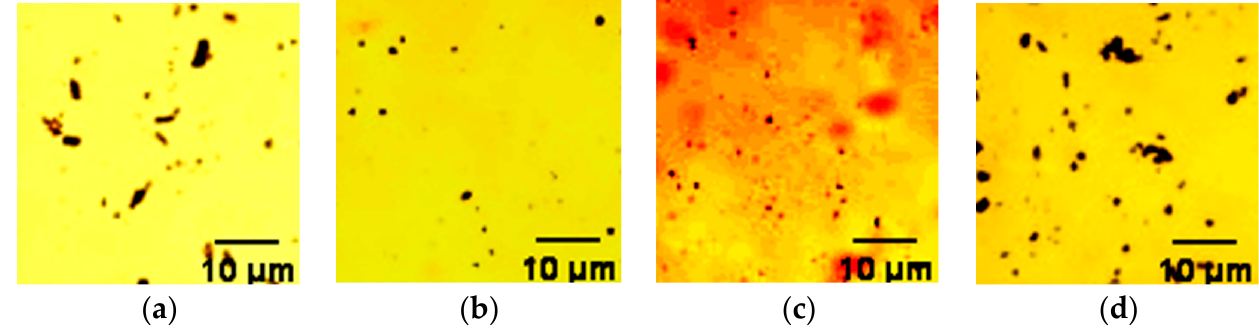
Figure 8. The morphology of asphaltene precipitates in the absence ( a ) and presence of biodiesel ( b ), oleic acid ( c ), and diesel oil ( d ).